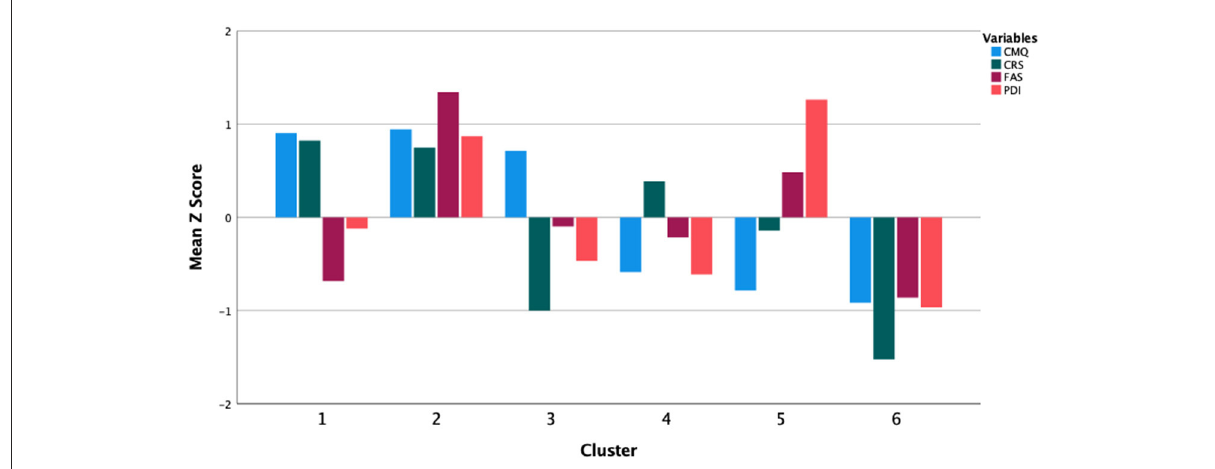
FIGURE1 Clusters associating conspiracy-mindedness with religiosity, delusional belief and social media addiction